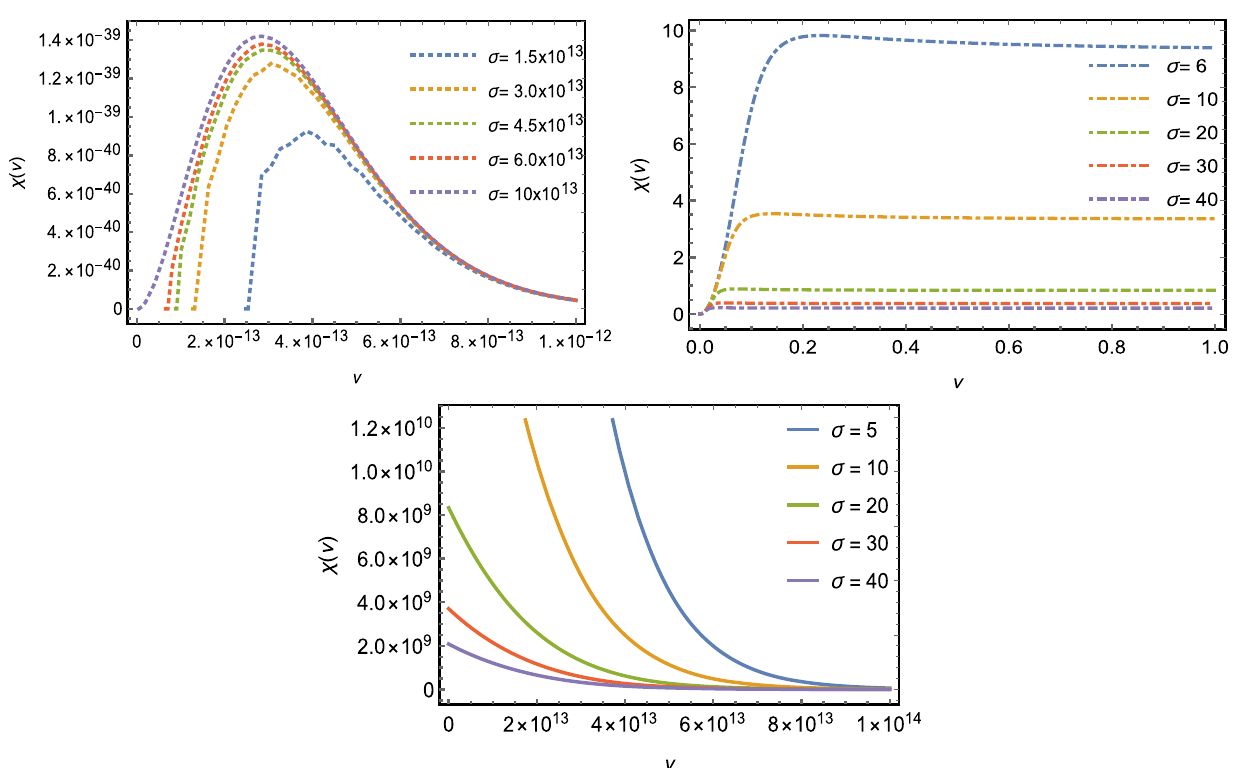
Fig. 1 The plots exhibit the spectral radiance χ(ν) changing for dif- ferent values of frequency ν and the Lorentz-breaking parameter σ (its unit is GeV − 1 ). The top left (dotted) is the configuration to the cos- mic microwave background, i.e., β = 10 13 GeV − 1 ; the top right (dot-